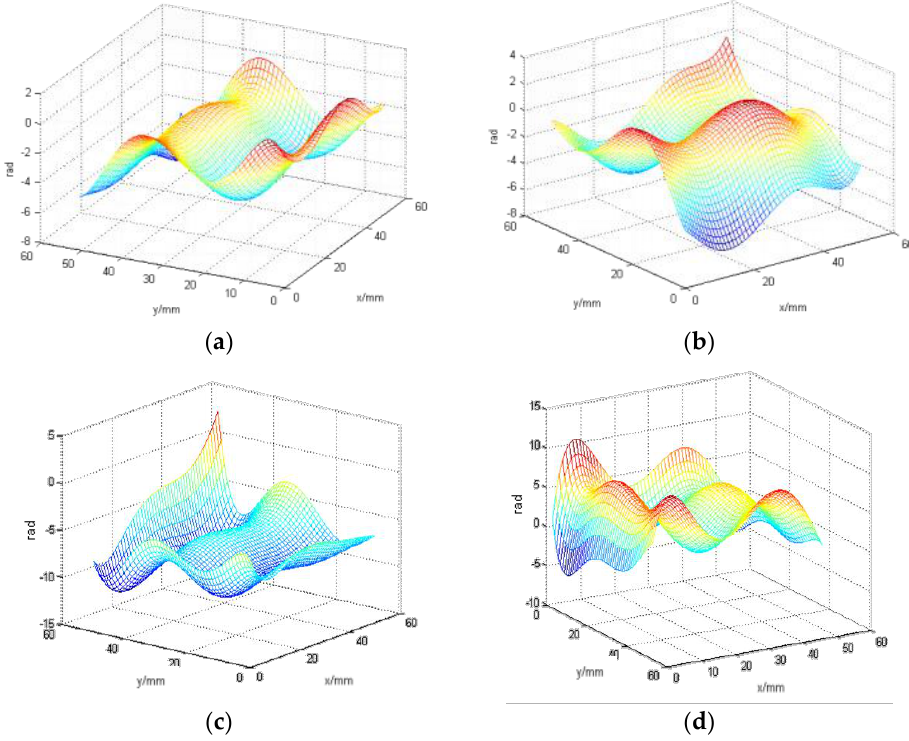
Figure 11. The results of wavefront reconstruction at the same distance with different water flow rates: ( a ) 10 L/min; ( b ) 20 L/min; ( c ) 30 L/min; and ( d ) 40 L/min.